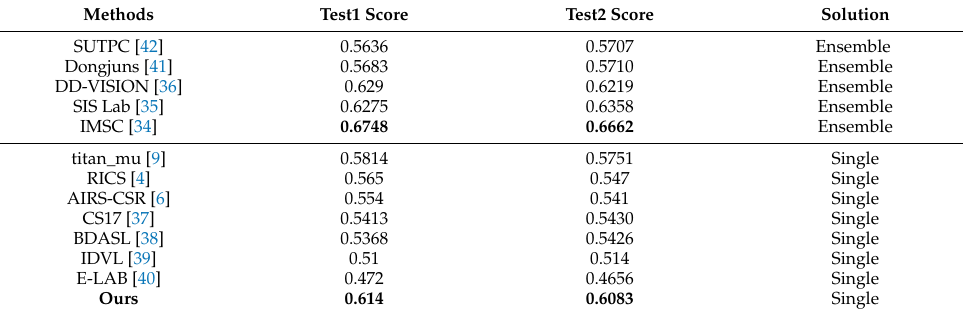
Table 4. Performance comparison on RDD2020 dataset.